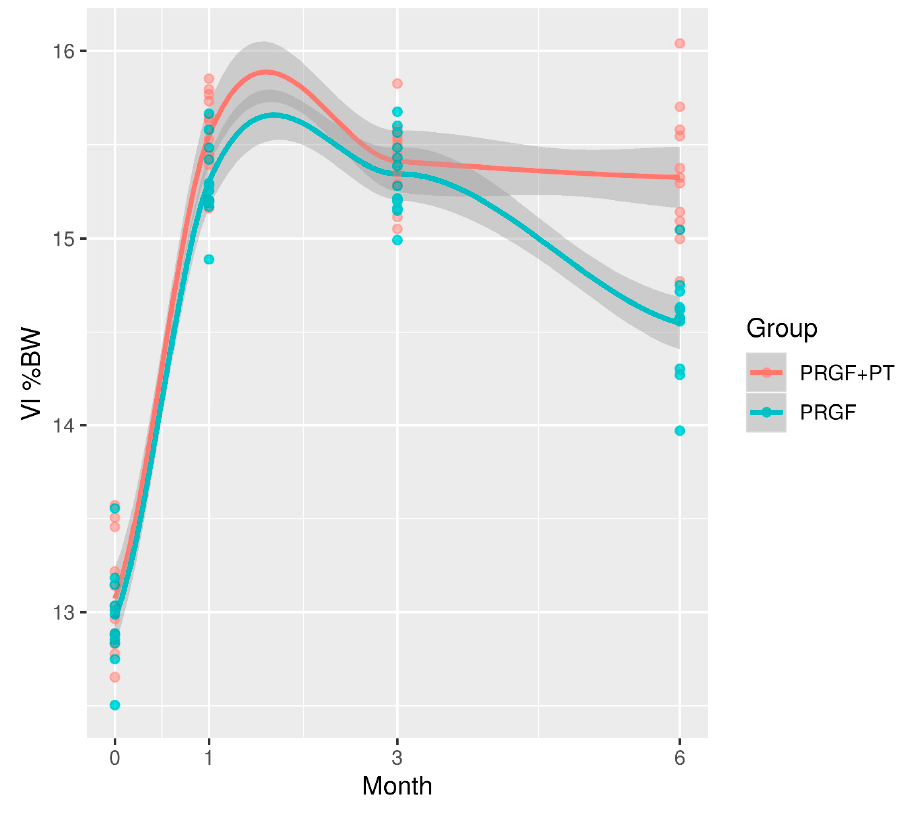
Figure 2. Evolution of VI (normalized to body weight) in both groups during the 180 days of the study. PRGF: Plasma rich in growth factors; PT: Physical therapy; VI: Vertical impulse.